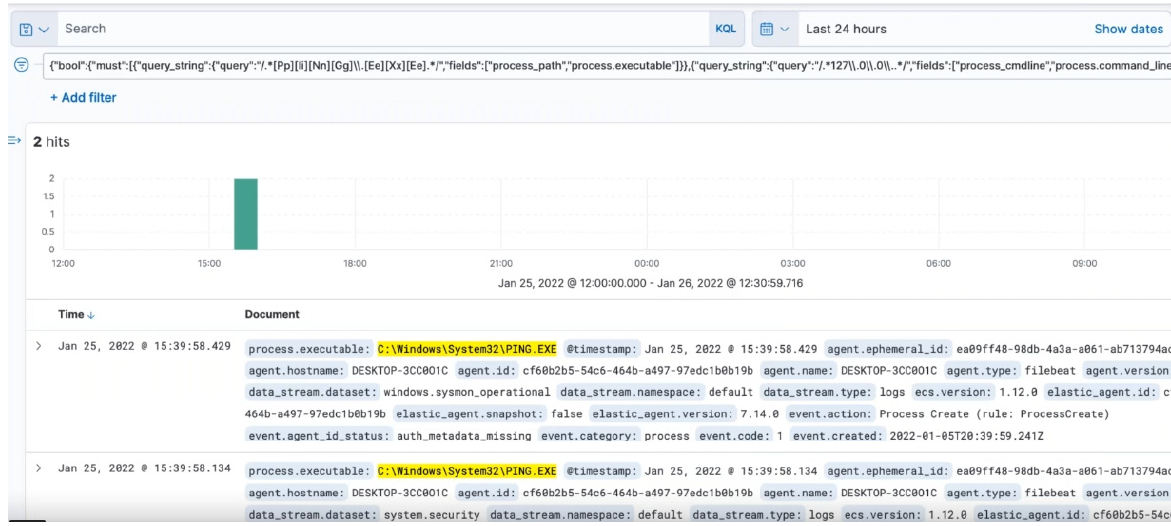
Figure 12. Search results for Ping and Loopback threat vectors.